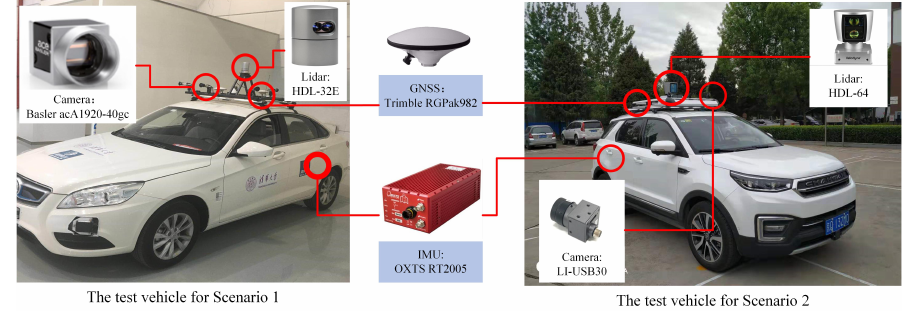
Figure 13. The experimental intelligent